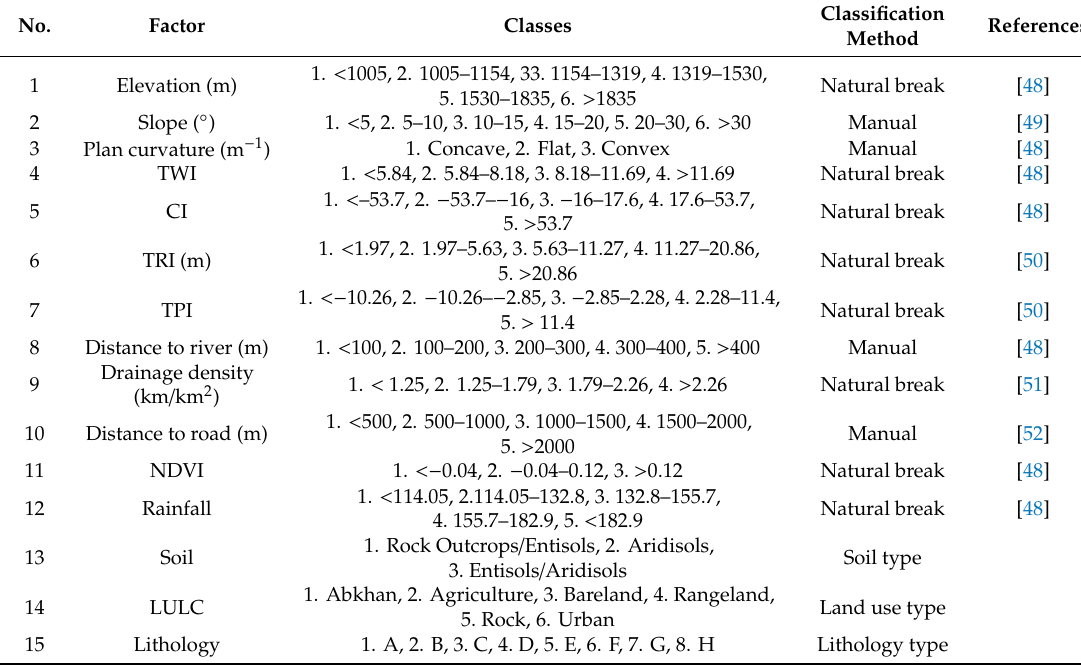
Table 1. Classes and classification method for the various thematic data